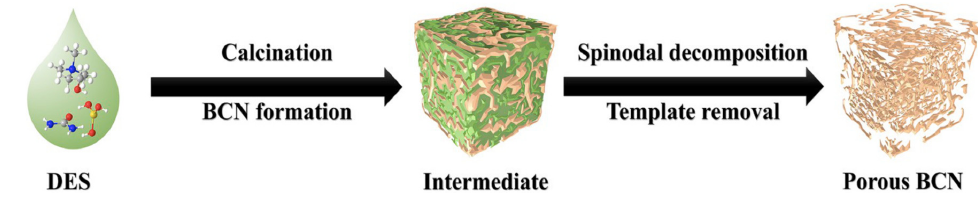
Figure 12. The synthetic route diagram of the porous BCN catalyst [95].